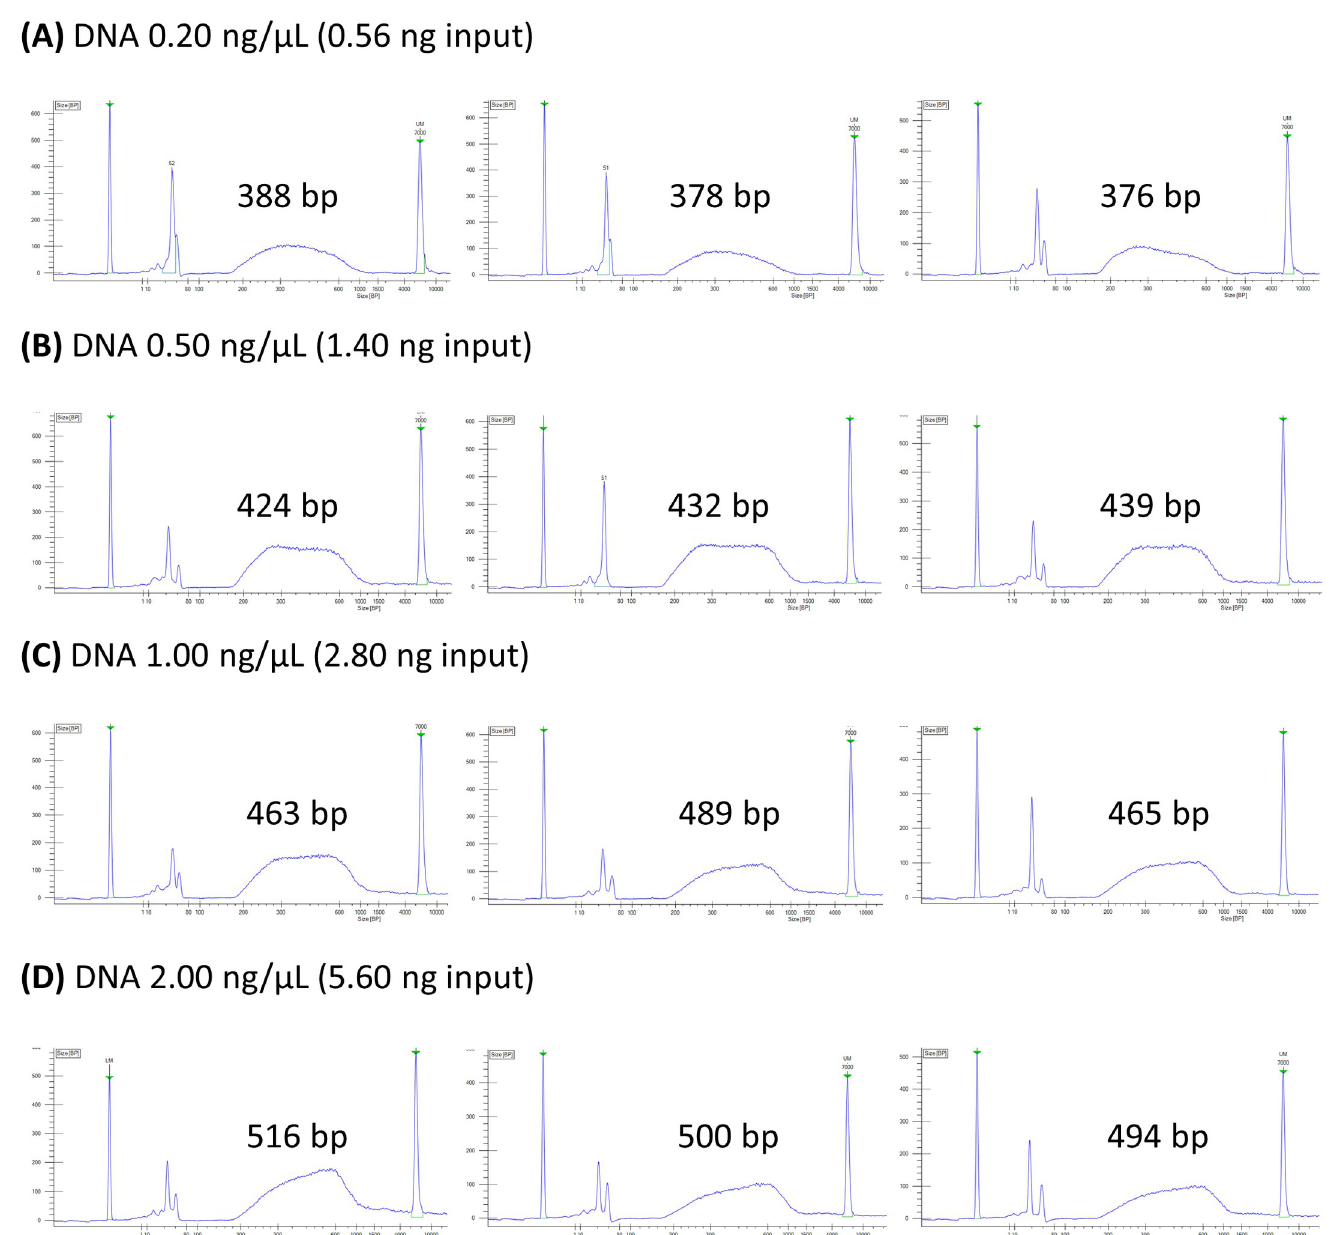
Fig 1. Distribution of fragment sizes for libraries generated with the presented cost-conscious protocol. Libraries were made for independent Eucalyptus viminalis samples with varying DNA inputs into the protocol. (A) Four samples with a starting DNA concentration of 0.20 ng/ μ L each (total 0.56 ng input each). (B) 0.5 ng/ μ L (1.40 ng input). (C) 1.00 ng/ μ L (2.80 ng input). (D) 2.00 ng/ μ L (5.60 ng input). Samples were tested on a LabChip GX Touch HT Nucleic Acid Analyzer (PerkinElmer), using high sensitivity reagents and LabChip according to the manufacturer’s instructions. Electropherogram plots size (bp) against fluorescence intensity and the average library size has been added (excluding the peaks of primers). LM and UM denote the LabChip lower and upper markers respectively (first and last peaks). Note the dual index primers and tagmentation adapters add 136 bp to the amplified library length, therefore library sizes approximately 436 bp are ideal for 150 bp paired-end sequencing.